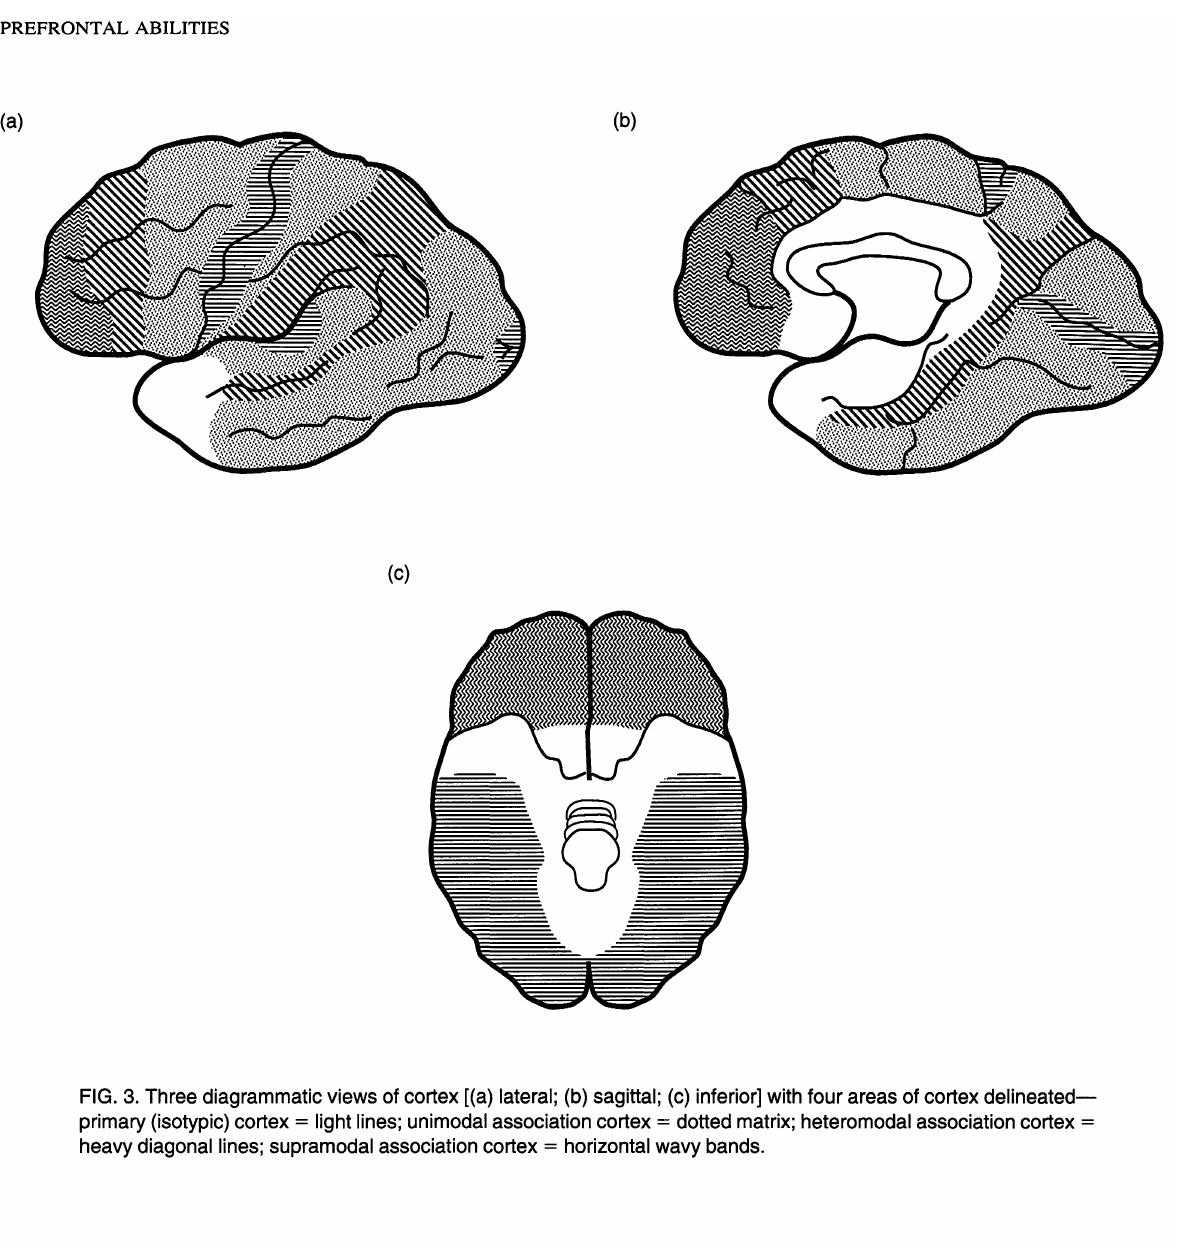
FIG. 3. Three diagrammatic views of cortex [(a) lateral; (b) sagittal; (c) inferior] with four areas of cortex delineated primary (isotypic) cortex = light lines; unimodal association cortex = dotted matrix; heteromodal association cortex = heavy diagonal lines; supramodal association cortex = horizontal wavy